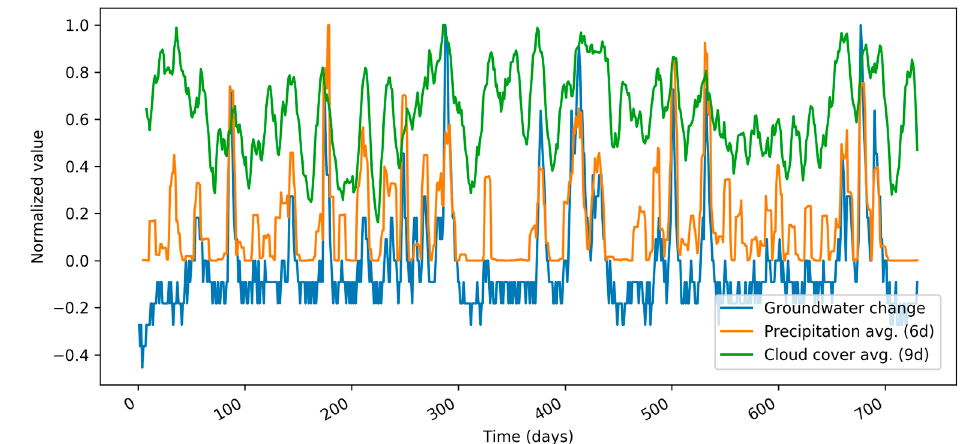
Figure 2. Plot of two distinct highly correlated attributes vs. groundwater change. Especially with precipitation average we can observe that many peaks correspond to peaks in groundwater level change.